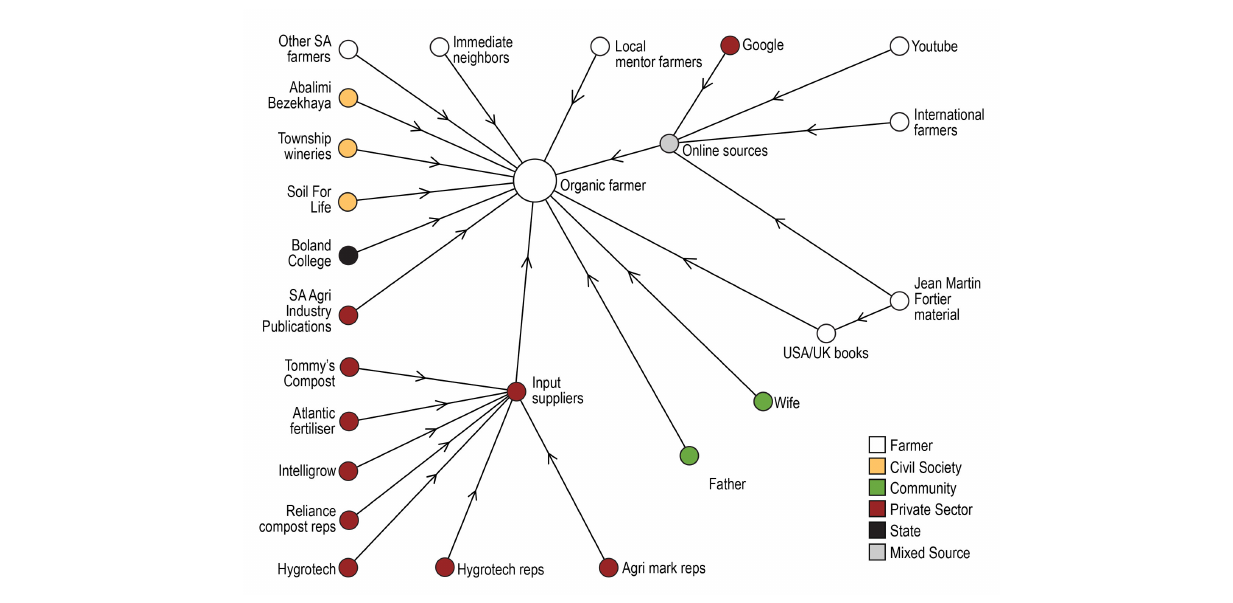
Fig. 2 . Combined network map of all actors identified by farmers as sources of information that influenced their